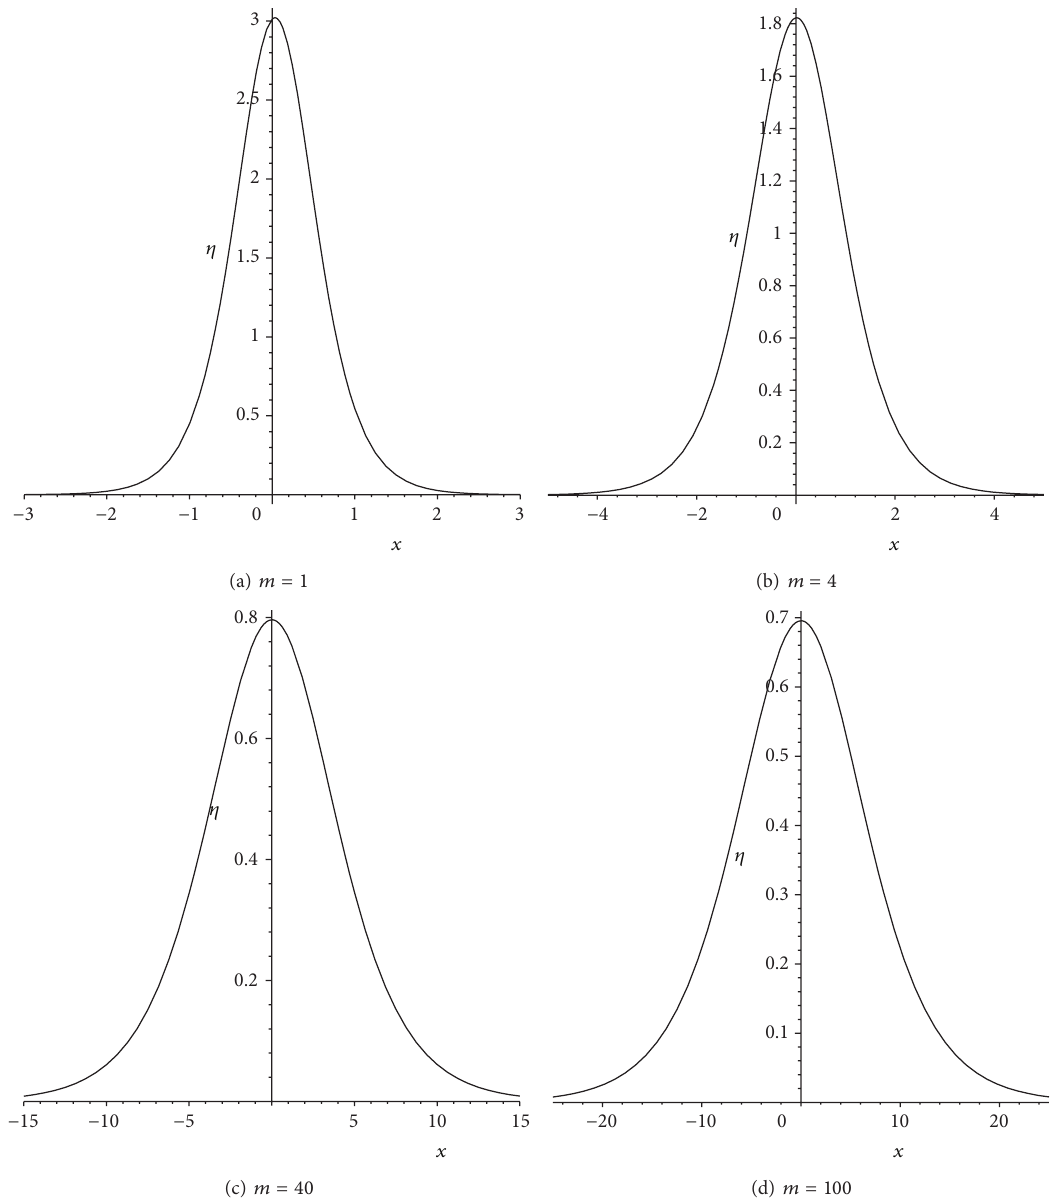
Figure 2: The graphs of solution (60) under some fixed parametric